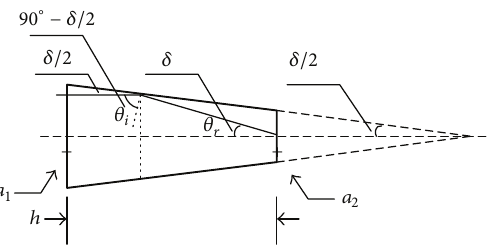
Figure 2: Cross section of a dielectric rod